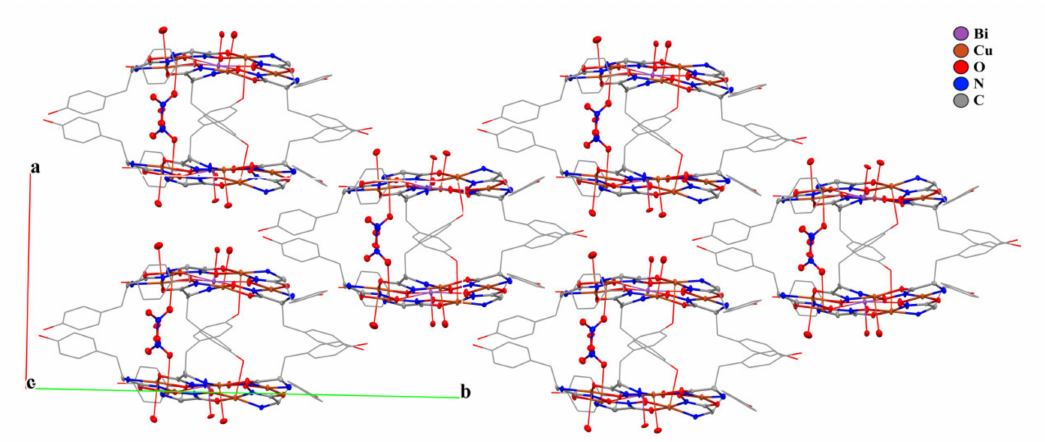
Figure 7. Fragment of crystal packing of complex 1 . All hydrogen atoms, uncoordinated NO 3 − , and solvate water molecules are omitted for